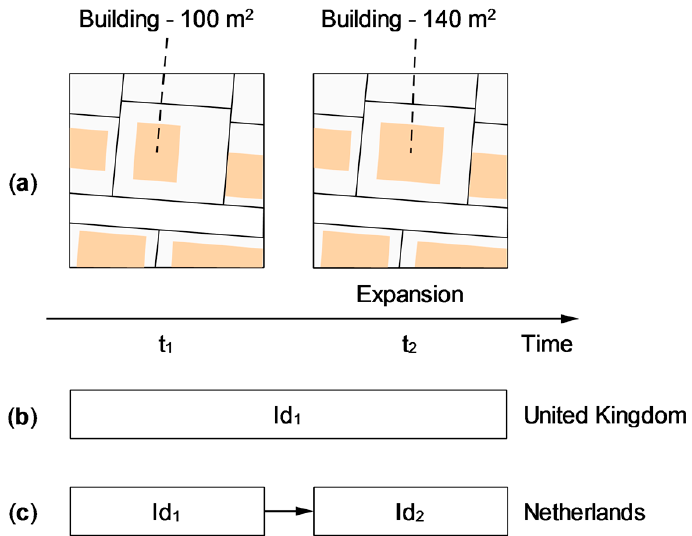
Figure 12. Example of a building with a surface area increased by 40% ( a ), in the first case the identifier of the object remains unchanged ( b ), in the second case, the identifier is replaced by a new one ( c ).